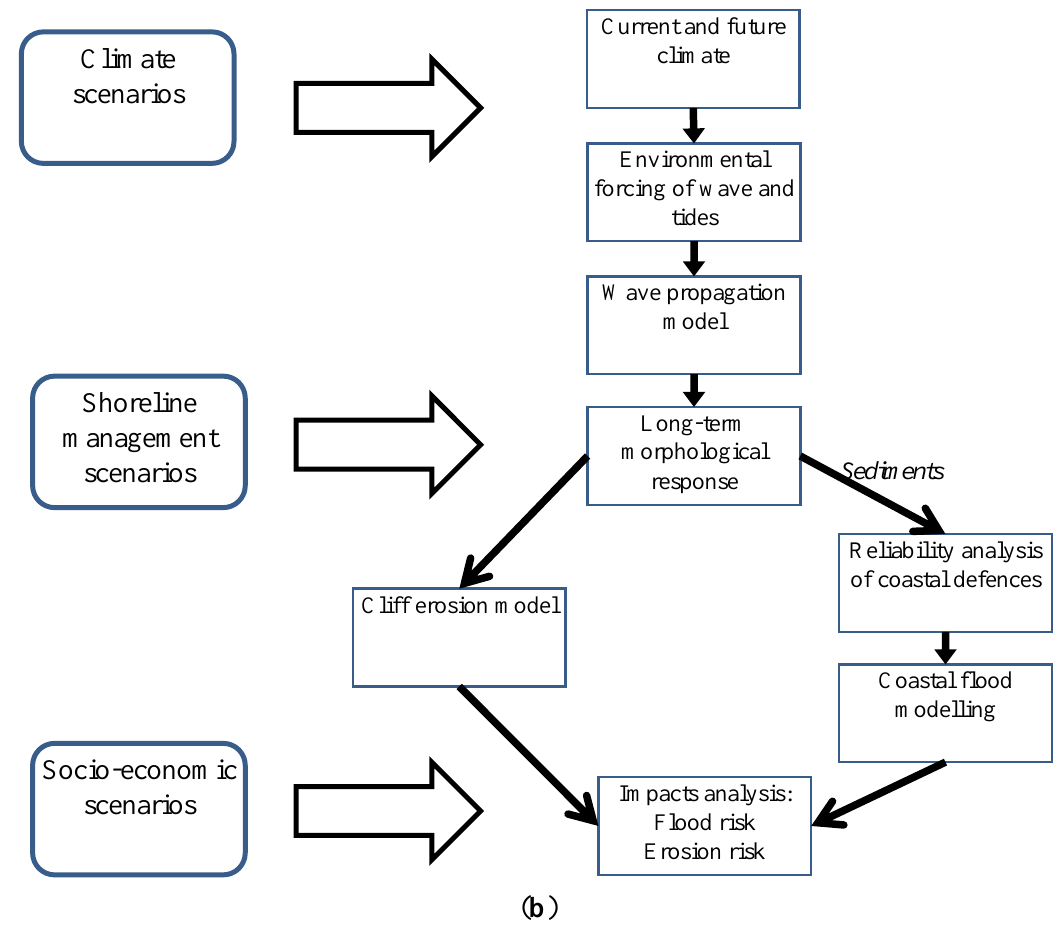
Figure 3. ( a ) Location of the study area in eastern England, showing the location of the major settlements and land elevation. The area of cliff erosion is indicated by the dotted line (from [20]). ( b ) Overview of the coastal flood and erosion climate change